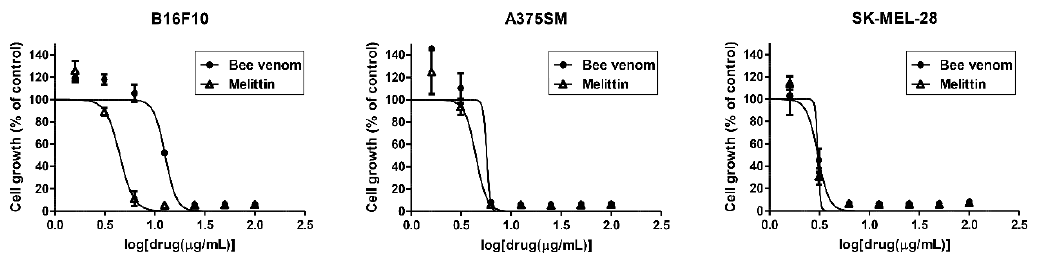
Figure 1. The effect of BV and melittin on the growth of melanoma cell lines. Cells were treated with various concentrations of BV and melittin for 72 h, and cell growth was measured using the MTT colorimetric assay. Data were presented as percentage relative to DMSO-treated control (% of control). Each value represents the mean ± SE from three independent experiments.